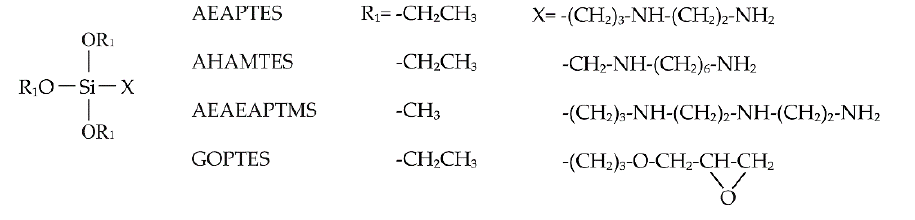
Figure 1. The structure of the silane coupling agents used in this study.